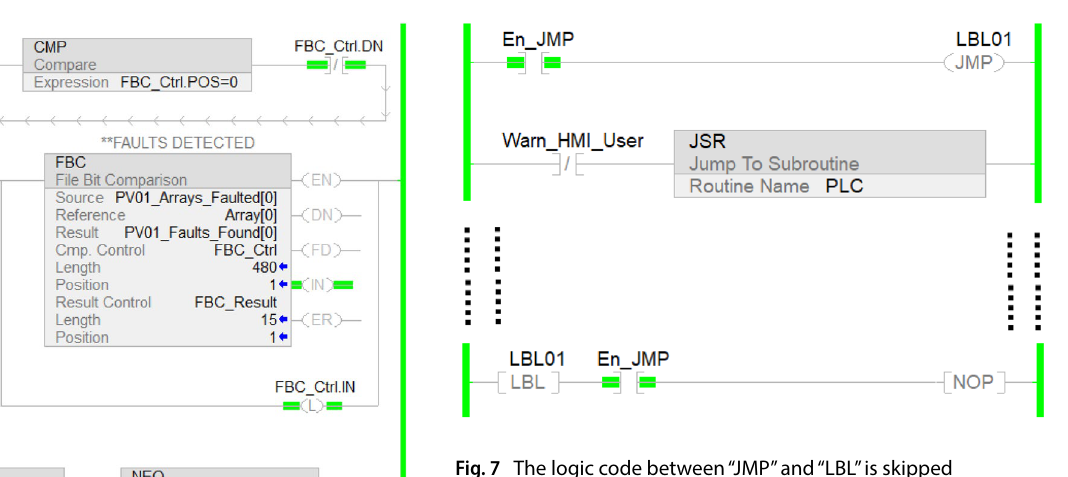
Fig. 7 The logic code between “JMP” and “LBL” is